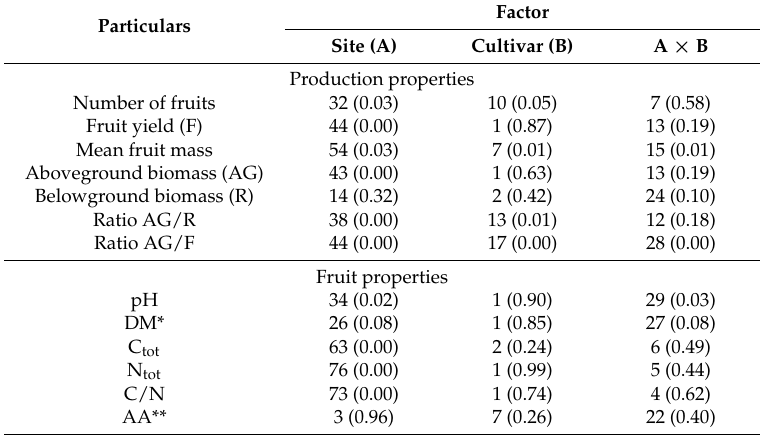
Table 5. The ANOVA results for husk tomato production and fruit properties: the contribution of factors (in %) to the total variance and the probability of a null hypothesis (in brackets).